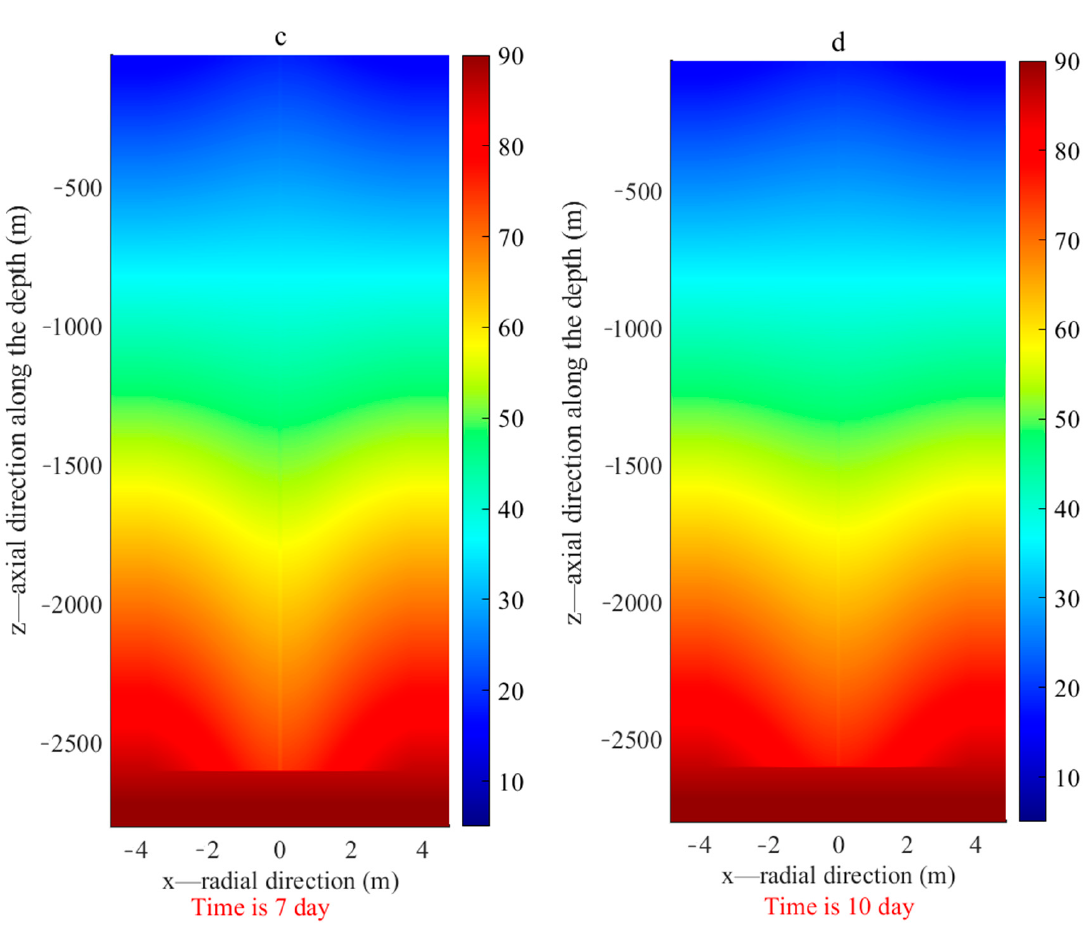
Figure 13. Temperature field recovery underground during the intermittence period after 30 days of low temperature heat storage (( a ): 1 day, ( b ): 2 day, ( c ): 7 day, ( d ): 10 day).